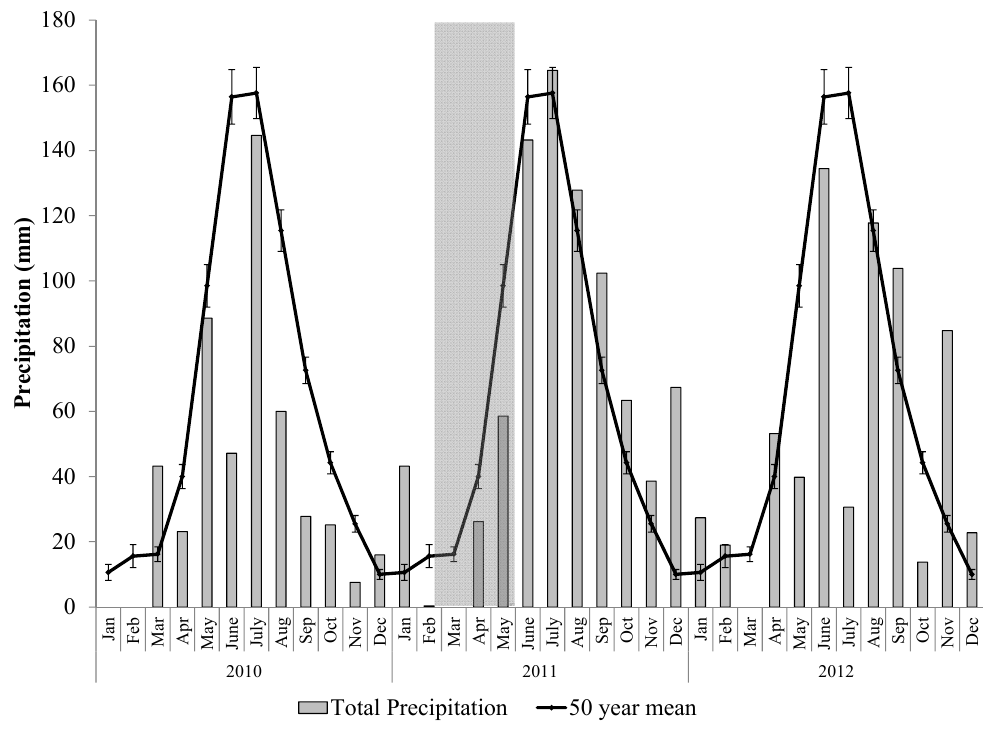
Figure 2. Monthly precipitation and fifty-year mean monthly precipitation (mm) for Perth, Western Australia (± standard error). Light shading denotes the period of forest disturbance in the Northern Jarrah Forest. Data reported is for Perth Airport, Station number 9021, Latitude 31.93°, Longitude